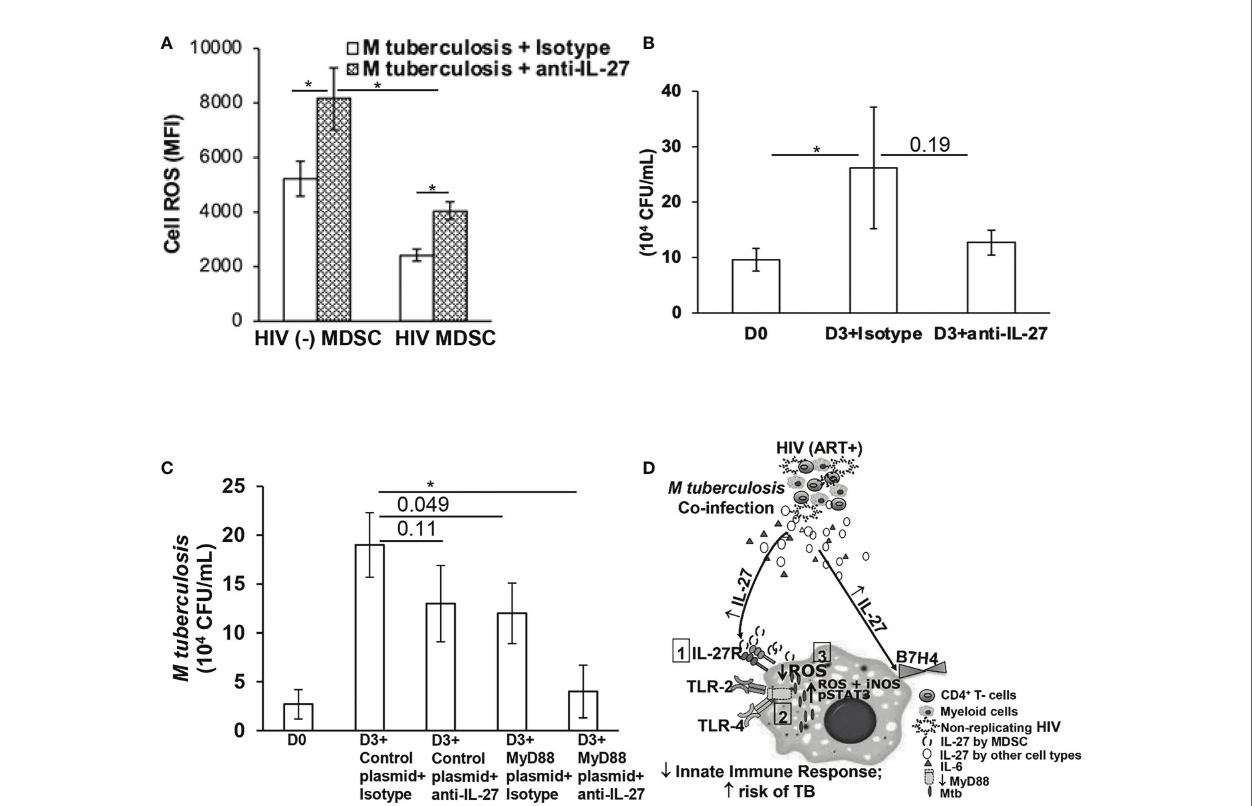
FIGURE 4 | IL-27 inhibits anti-mycobacterial activity of MDSC. To determine that IL-27 inhibits anti-mycobacterial activity of MDSC, HIV (-) MDSC and HIV MDSC were isolated as in Figure 1 using fl ow cytometry and (A) infected with Mtb-GFP at MOI of 1:5, in the presence of neutralizing IL-27 or isotype matched control antibody for 2-hrs. During last 30-mins of infection 1 µM of CellROX deep read reagent was added and subsequently stained with aqua fl uorescent LIVE/DEAD stain. Expression of ROS (Cell ROS) in Mtb-GFP+ Live cells was determined by fl ow cytometry and Mean Fluorescence Intensity (MFI) calculated. Net ROS expression was calculated as in Materials and Methods . (B) MDSC were infected for 3-hrs, washed with PBS to remove extracellular bacteria and cultured with neutralizing IL-27 or isotype matched control antibody. M tuberculosis growth (colony forming units (CFU)/ml) was determined in the cellular lysates at day-0 and -3 post-infection (p.i.). (C) MDSC were transfected with empty (Control) or MyD88 expressing plasmid using Lipofectamine 3000. After 16-18 hrs post-transfection, were infected with M tuberculosis at MOI of 1:5 for 3-hrs washed with PBS to remove extracellular bacteria and cultured with neutralizing IL-27 or isotype matched control antibody. M tuberculosis growth (colony forming units (CFU)/ml) was determined in the cellular lysates at day-0 and -3 post-infection (p.i.). (D) Regulation of immunity in HIV-Mtb co-infection: HIV-infected individuals on cART with suppressed HIV replication have increased IL-27 and MDSC in these individuals exhibit (1) higher expression of IL- 27R, (2) lower expression of MyD88 which abrogates TLR-signaling and (3) reduced expression of Reactive Oxide Species (ROS) in response to M tuberculosis . The histograms show mean values +/- SEM; N=4 donors. *p <